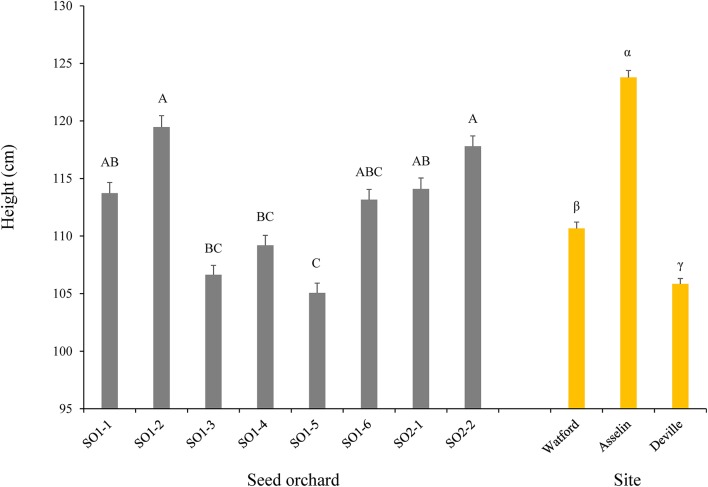
Plant height as a function of seed orchard and forest planting site at the end of the fourth growing season (n = 768 seedlings per seed orchard and n = 2,048 seedlings per site for a total of 6,144 seedlings). The means (± standard error) with the same letter within seed orchard or site are not significantly different according to a Tukey test at α = 0.05.